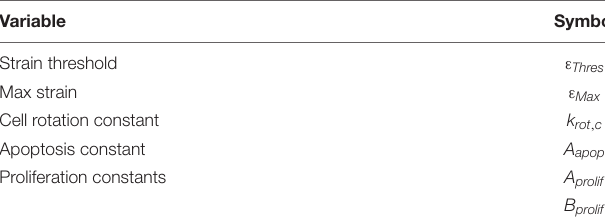
Frontiers in Bioengineering and Biotechnology |